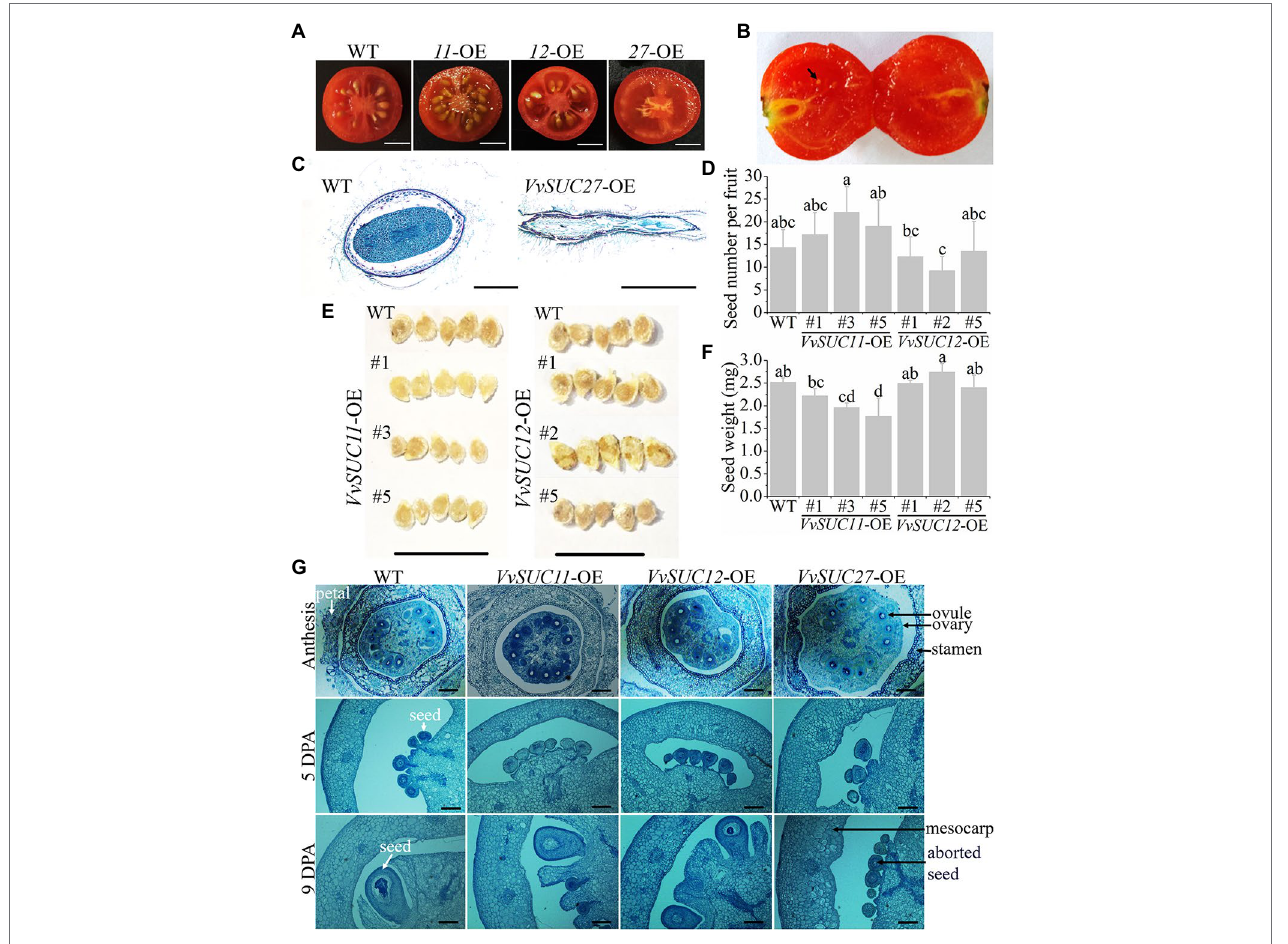
FIGURE 5 | Observation of VvSUC -OE tomato seeds. (A) Crosswise cutting of fruits at the red ripe stage of the WT and VvSUC -OE lines. Scale bar, 50 mm. (B) Crosswise cutting of VvSUC27 -OE fruits at the red ripe stage. Black arrow indicates aborted seed. Scale bar, 50 mm. (C) Normal seed from WT and aborted seed from VvSUC27 -OE fruit observed microscopically. Cross-cut tissue slices were stained with safranin O/fast green. Scale bar, 500 μ m. (D) Comparison between the WT, VvSUC11 -, and VvSUC12 -OE lines regarding seed number per fruit. Error bars indicate mean ± SD of twenty biological replicates. Different lowercase letters show statistically significant differences among WT, VvSUC11-, and VvSUC12-OE lines (Tukey’s test, p < 0.05). (E) Comparison between the WT and VvSUC11 - or VvSUC12 -OE lines regarding seed shape and size. Scale bar, 1 cm. (F) Comparison between the WT, VvSUC11 - and VvSUC12 -OE lines regarding seed weight. Error bars indicate mean ± SD. The single seed weight was calculated from the average of the total weight of every 15 seeds, which was recorded as one experiment of ten biological replicates. Different lowercase letters show statistically significant differences among WT, VvSUC11-, and VvSUC12-OE lines (Tukey’s test, p < 0.05). (G) Ovary and cell division phase of the WT and VvSUC -OE lines observed microscopically. Anthesis, 5 and 9 days post-anthesis (DPA) of the WT and VvSUC -OE lines were selected to observe the ovule and seed development. Cross-cut tissue slices were stained with safranin O/fast green. Ovule, seed, aborded seed and some other parts were indicated by arrows and noted beside. Scale bar, 200 μ